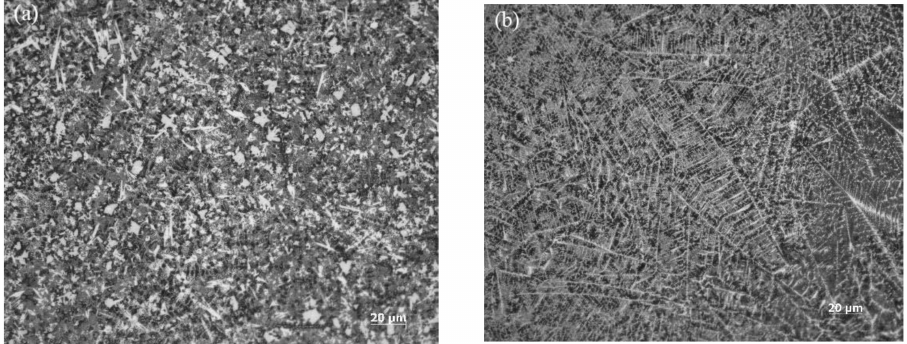
Figure 7. Sample structure with electromagnetic field assistance. ( a ) Microstructure at point C of Figure 5a; ( b ) microstructure at point B of Figure 5a.